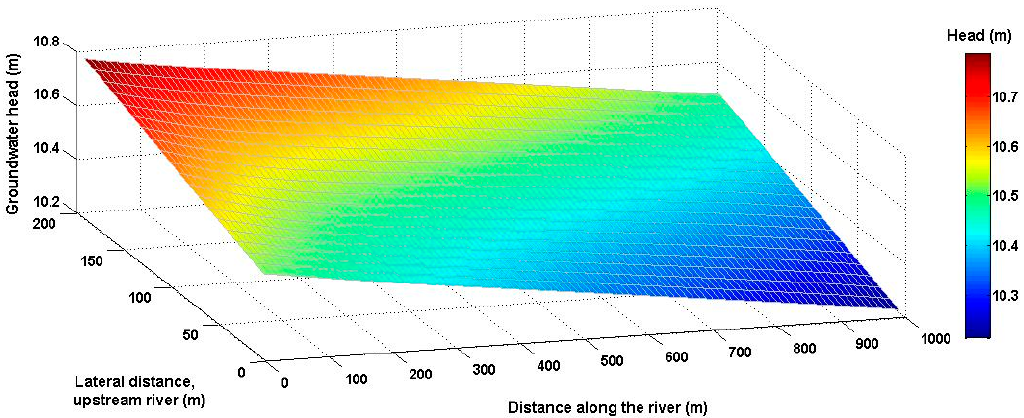
Figure 9. Groundwater head obtained from STRIVE for the Aa River based on interpolated river boundary with a steady-state simulation.